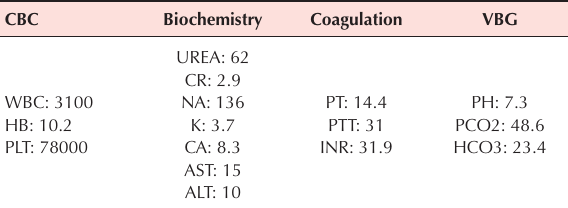
Table 1. Patient blood tests before surgery CBC Biochemistry Coagulation